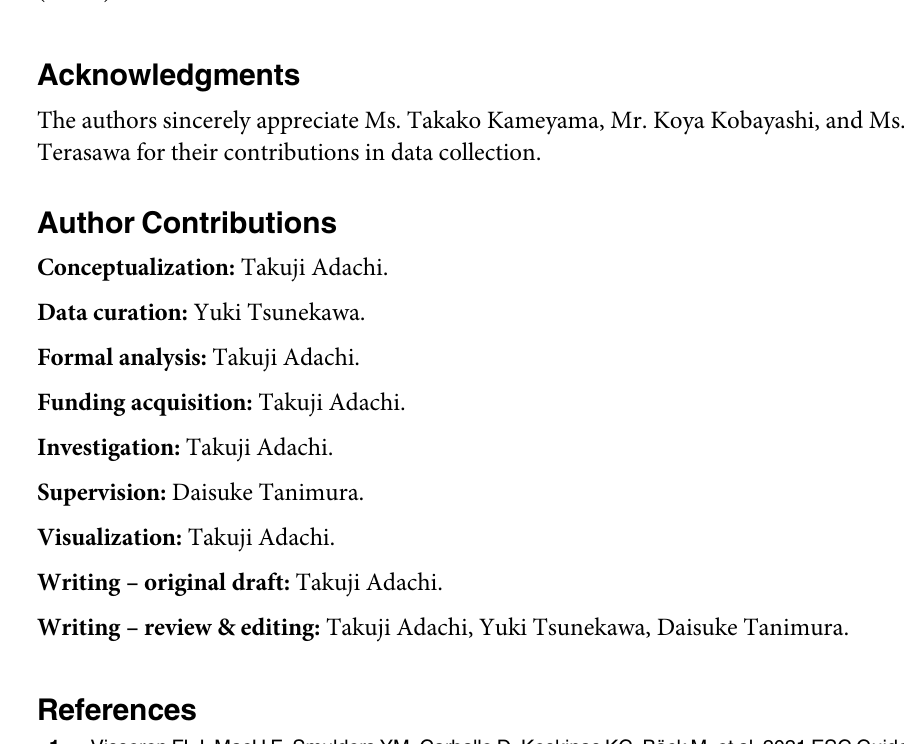
S1 Table. Big Five personality traits according to the patient characteristics. S2 Table. Results of multivariate logistic regression analysis for the association between Big Five personality traits and four domains of medication adherence (dependent vari-